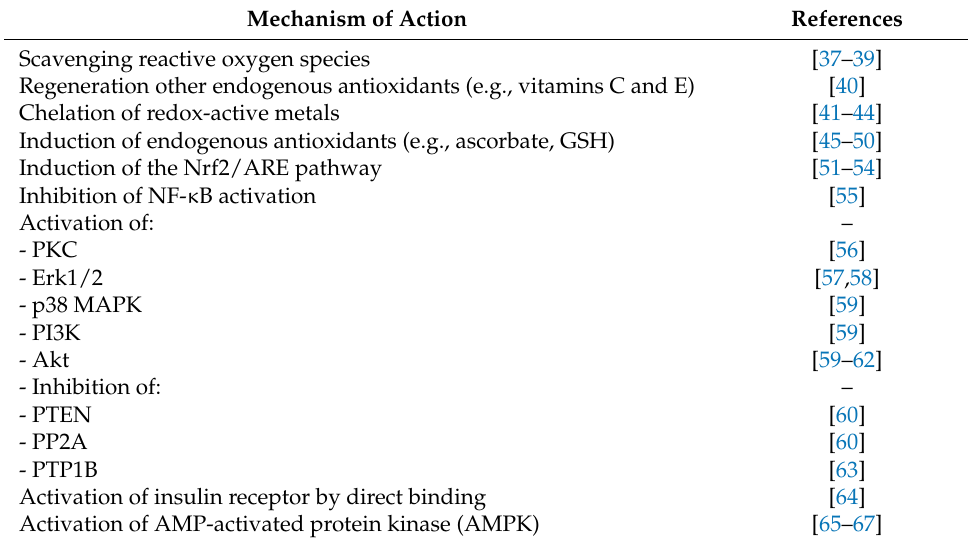
Table 1. Proposed mechanisms of action of LA. Mechanism of